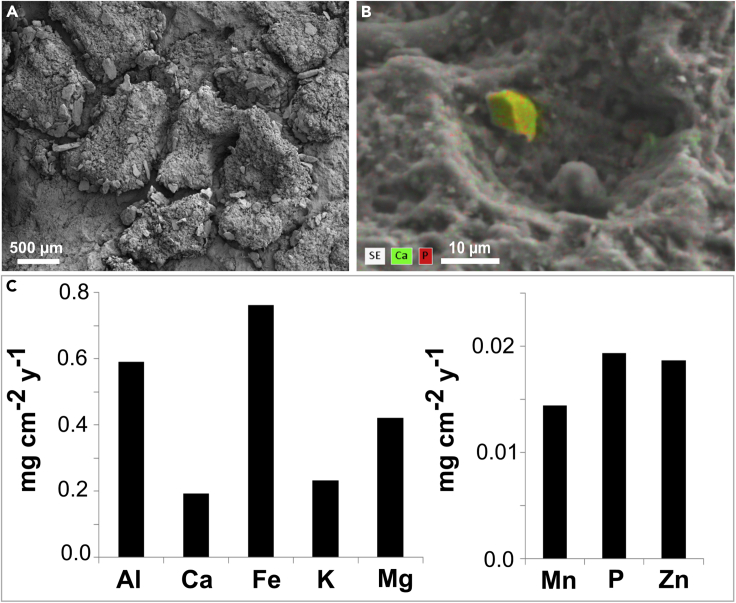
Mineral Accumulation on Grit Surface and Elemental Dust Composition(A) SEM image of lichen thalli attached to grit with mineral particles from dust on the cortex of the thalli; (B) Artificially colored close-up SEM-EDX image of dust particle on top of lichen thalli showing a grain consisting of Ca and P compounds; (C) Elemental deposition by dust. SEM, scanning electron microscopy; EDX, energy-dispersive X-ray spectroscopy.